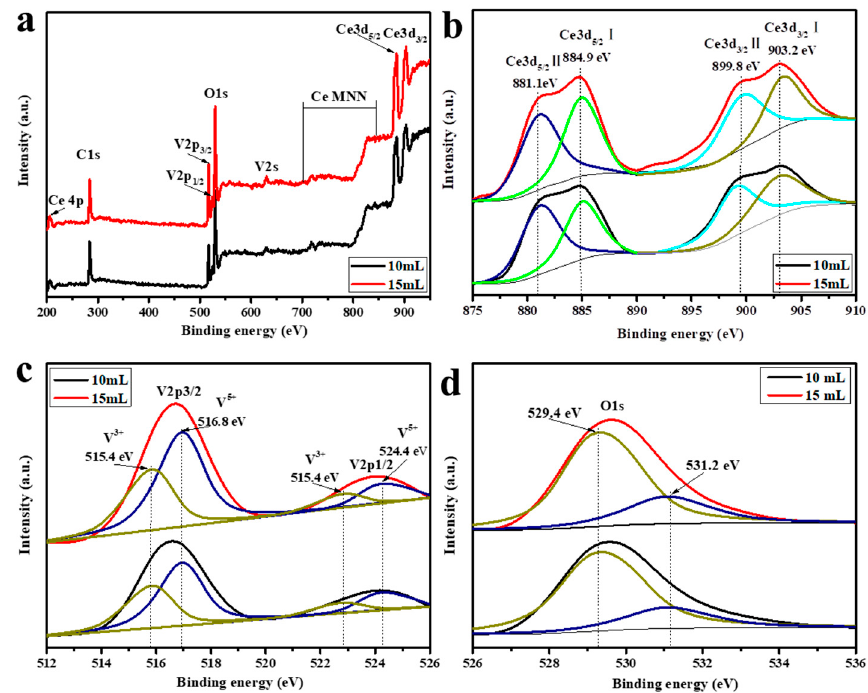
Figure 3. XPS results of the samples synthesized in the solutions containing 10 and 15 mL EG of survey ( a ), Ce 3d ( b ), V 2p ( c ) and O1s ( d ).